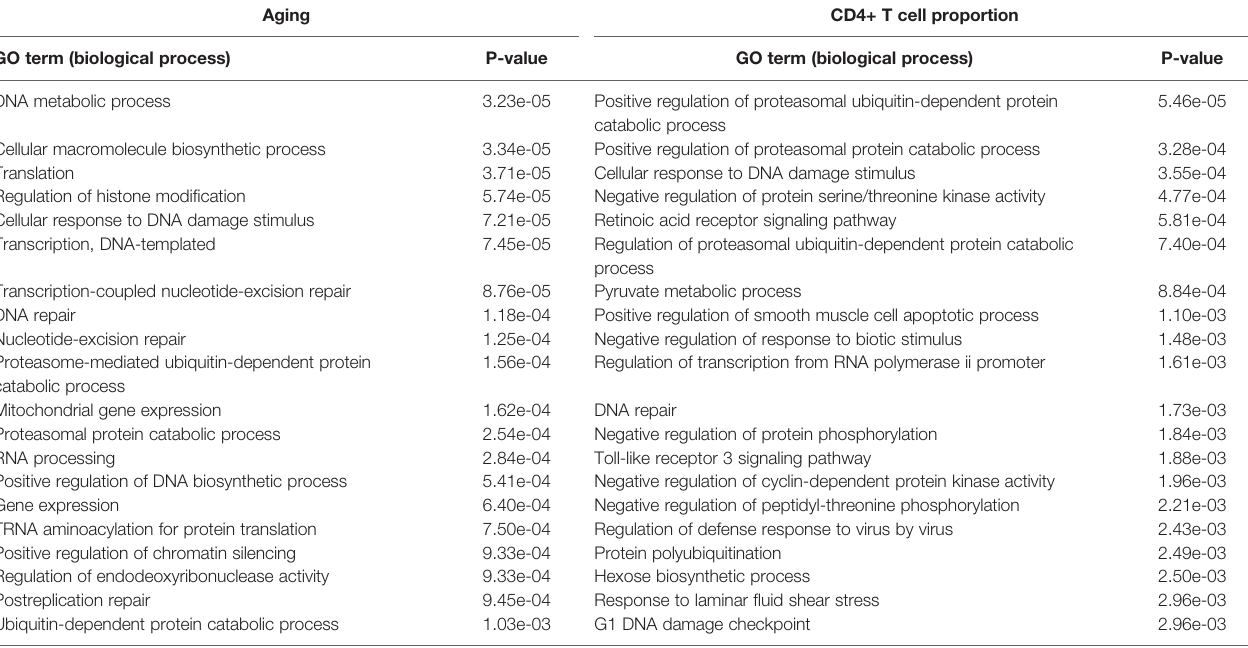
TABLE 3 | The signi fi cantly enriched GO biological process terms of the aging- and CD4+ T cell proportion-derived differential genes (top 20). Aging